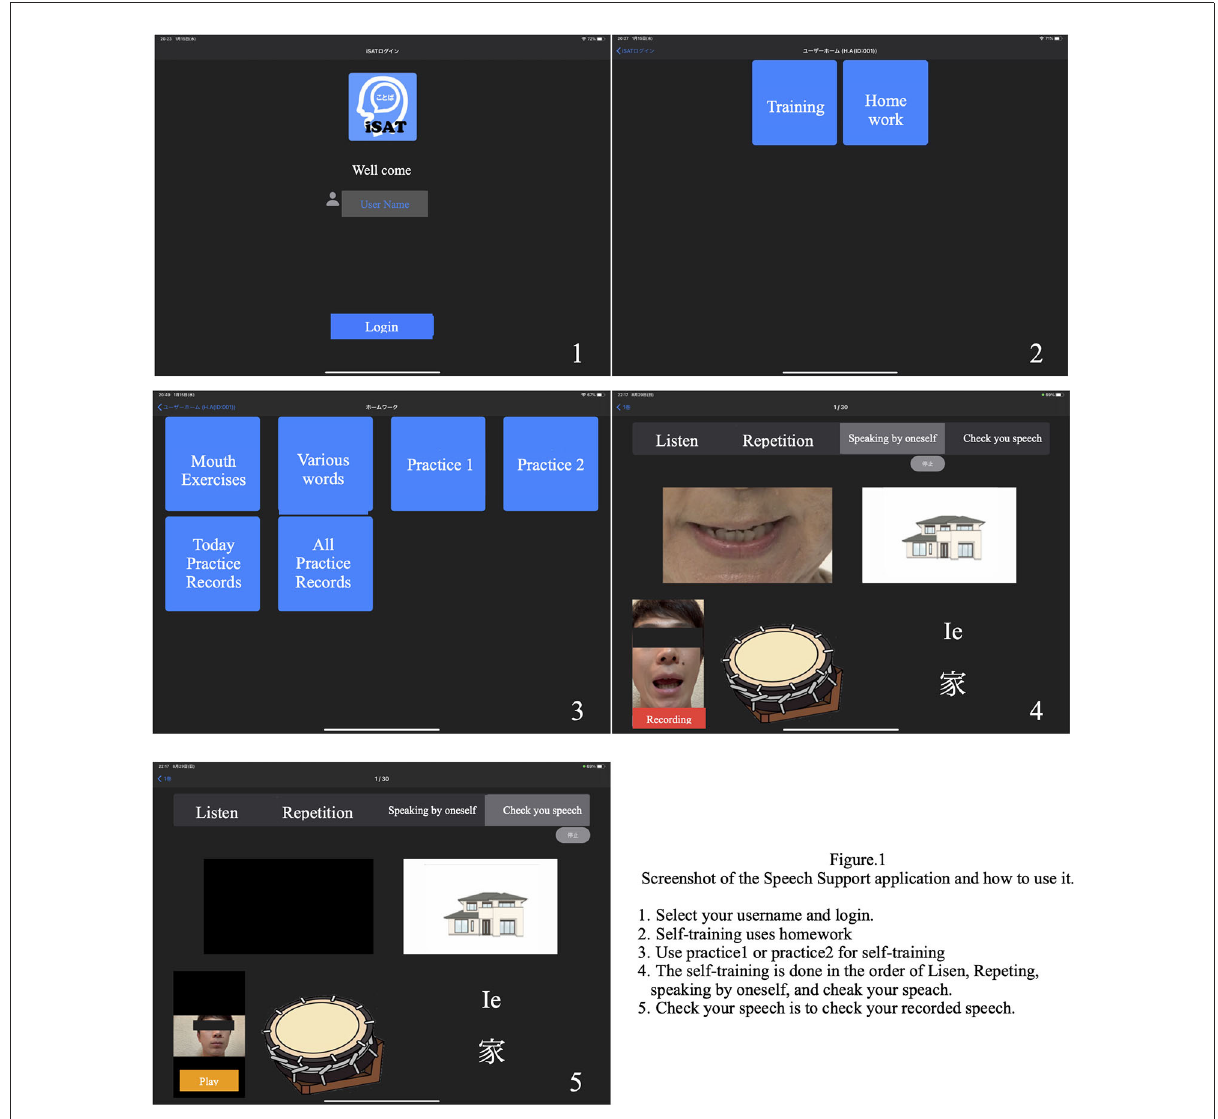
FIGURE1 Speech therapy support application